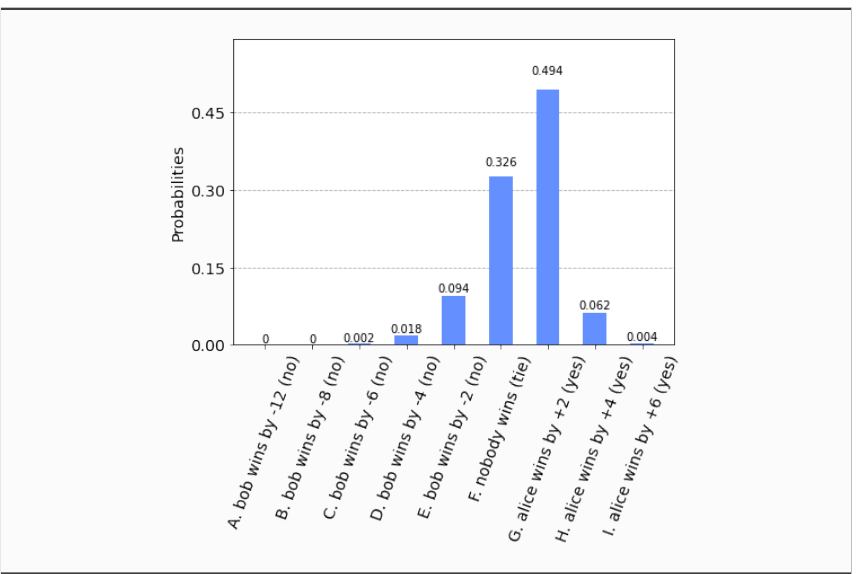
Figure 14. The possible outcomes and their probabilities when r A = 0.50 and r B = 0.25.